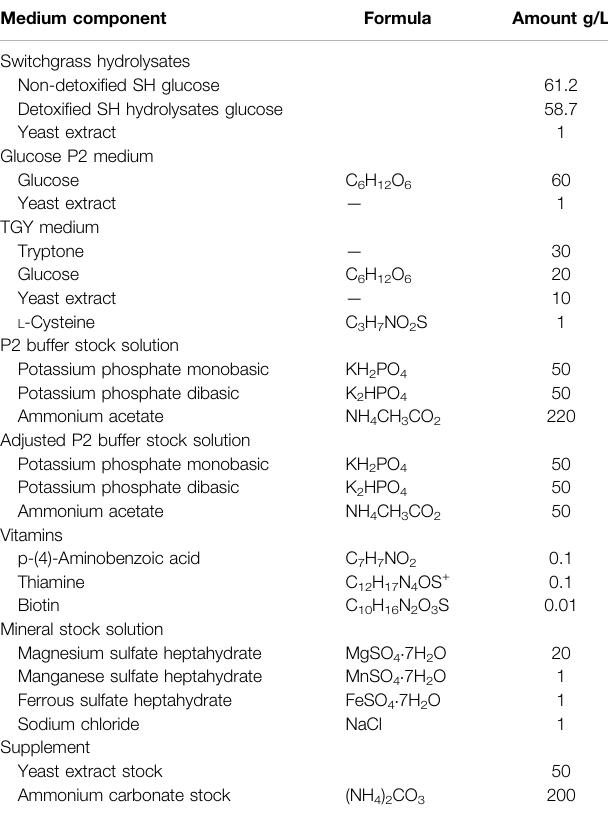
TABLE 1 | Compositions of fermentation and preculture media and stock solutions used in the fermentation of SH by Clostridium beijerinckii . Medium